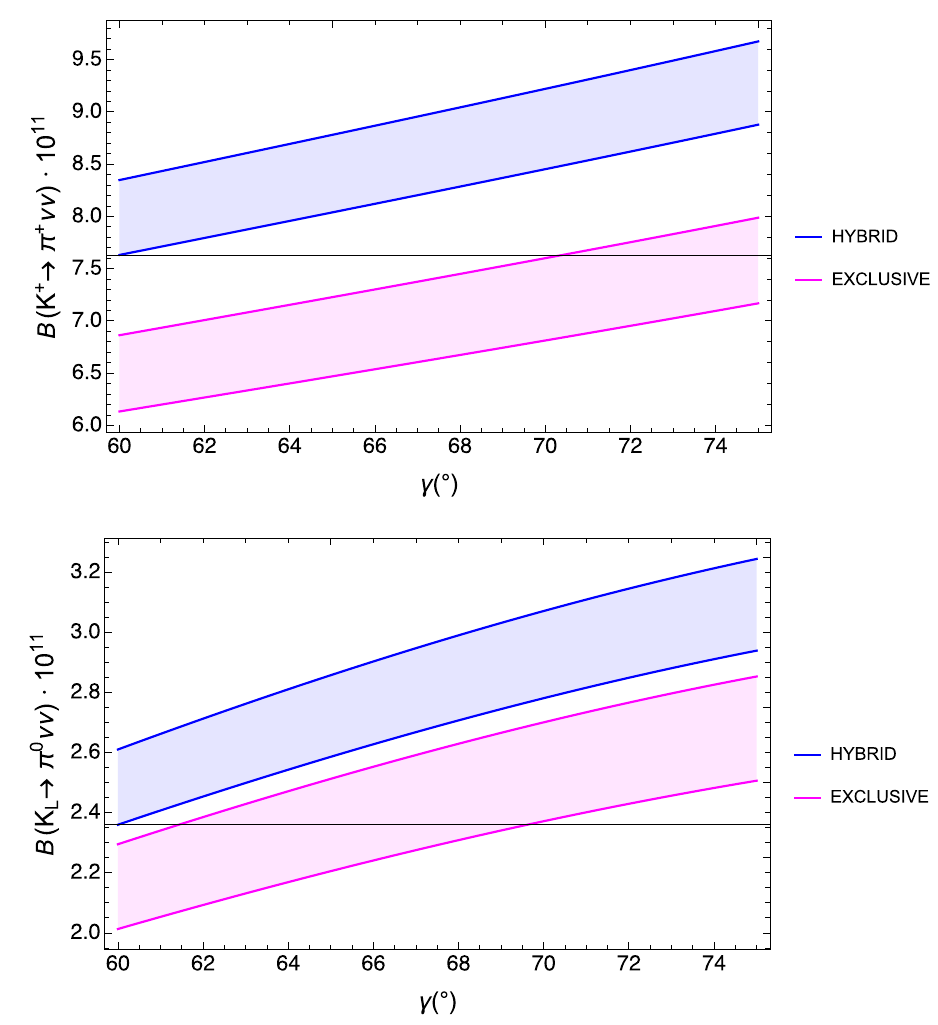
Fig. 4 The branching ratios B ( K + → π + ν ¯ ν) and → π 0 ν ¯ ν) as functions of B ( K L γ , in the EXCLUSIVE and HYBRID scenarios. The bands represent the uncertainties related to | V cb | , | V ub | , | V us | and to the non-CKM